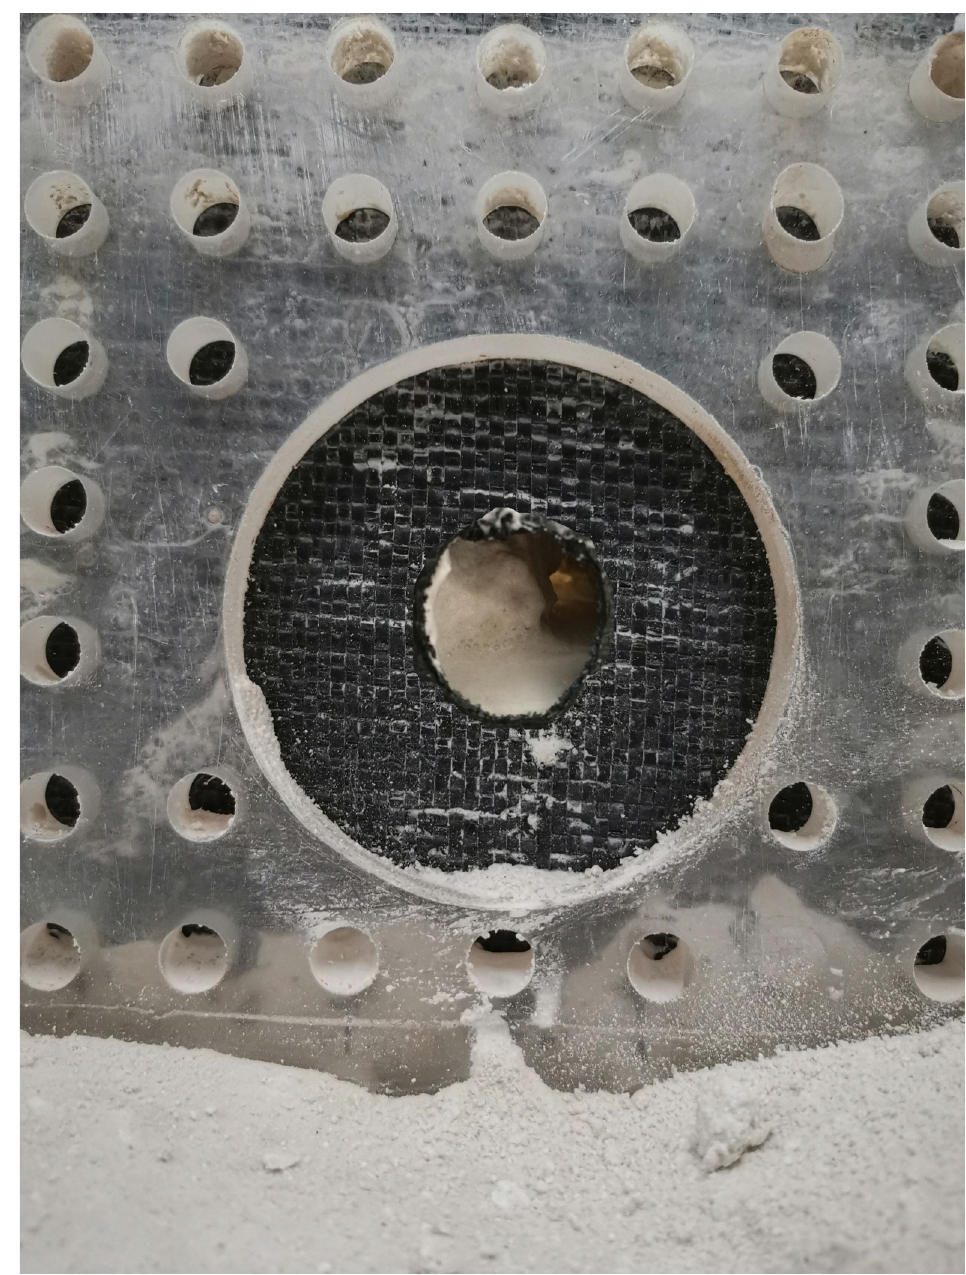
Fig 7. Formation of horizontal soil flow channel after seepage failure of Soil